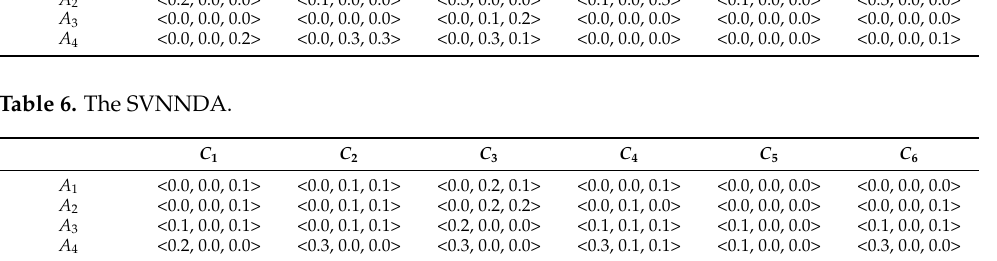
SVNNDA, using Equations (33) and (34), as well as appraisal score, using Equation (35), the values of the weighted sum of SVNPDA and SVNNDA are transformed into crisp values using Equation